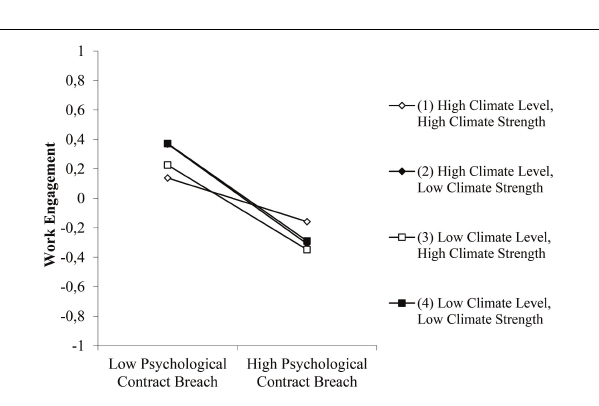
FIGURE 3 | The three-way interaction between PCB, commitment climate level, and commitment climate strength in relation to work